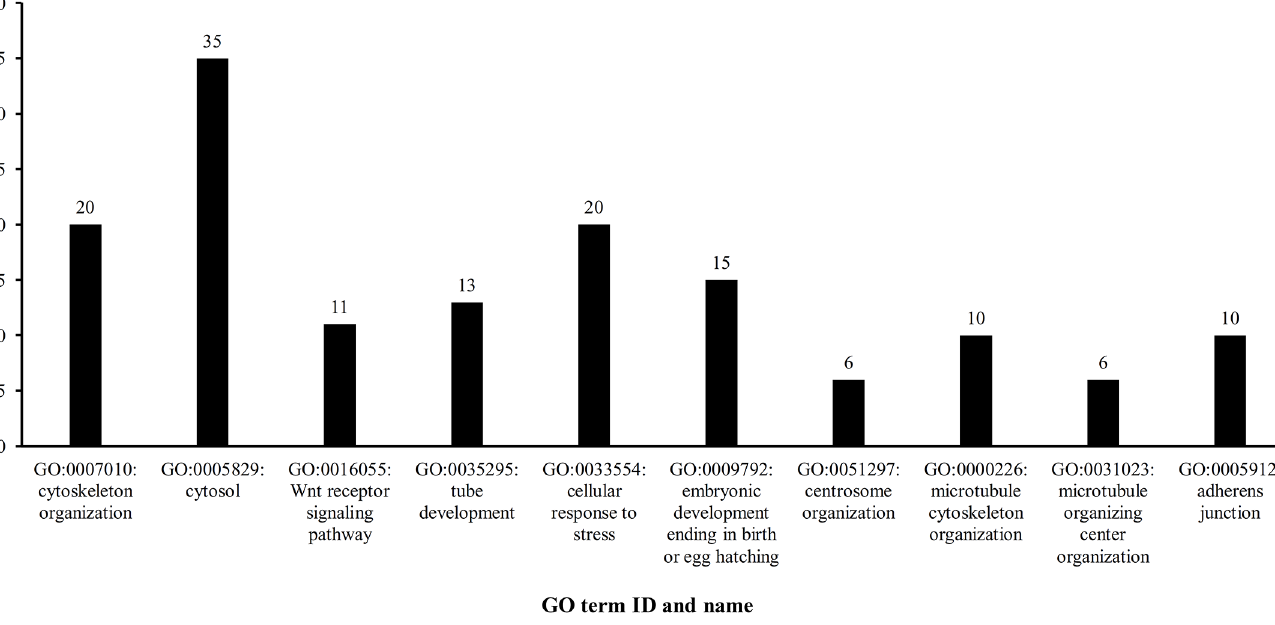
PLOS ONE | DOI:10.1371/journal.pone.0129474 June 9,